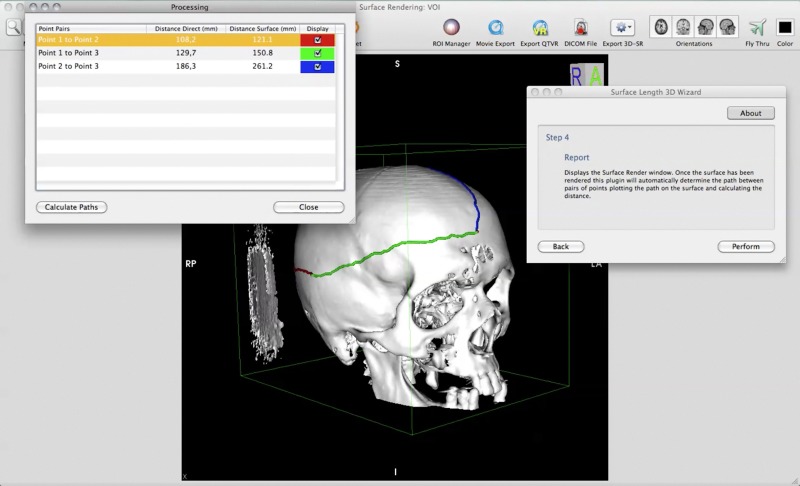
Example application of surface length plugin to measurement of bony structures of the skull.